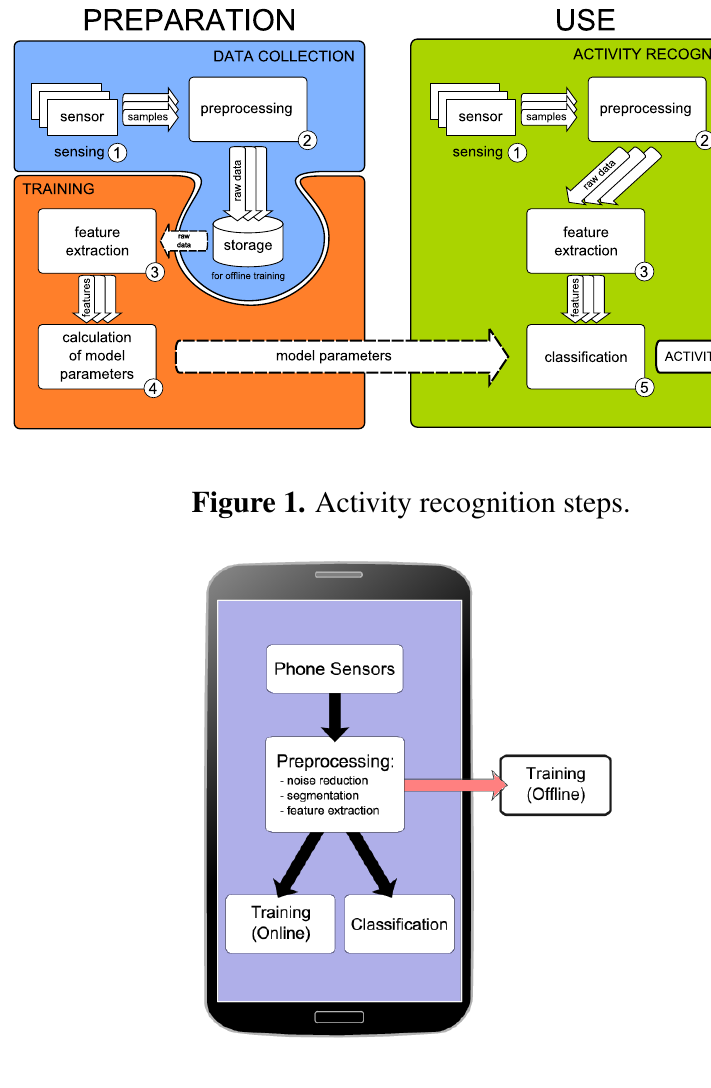
Figure 2. Local approach for activity recognition on mobile